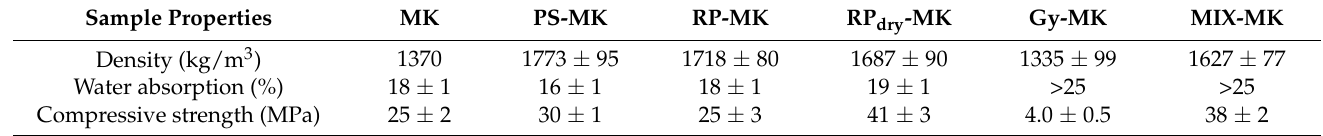
Table 5. Physical and mechanical properties of the geopolymer sample (MK) and